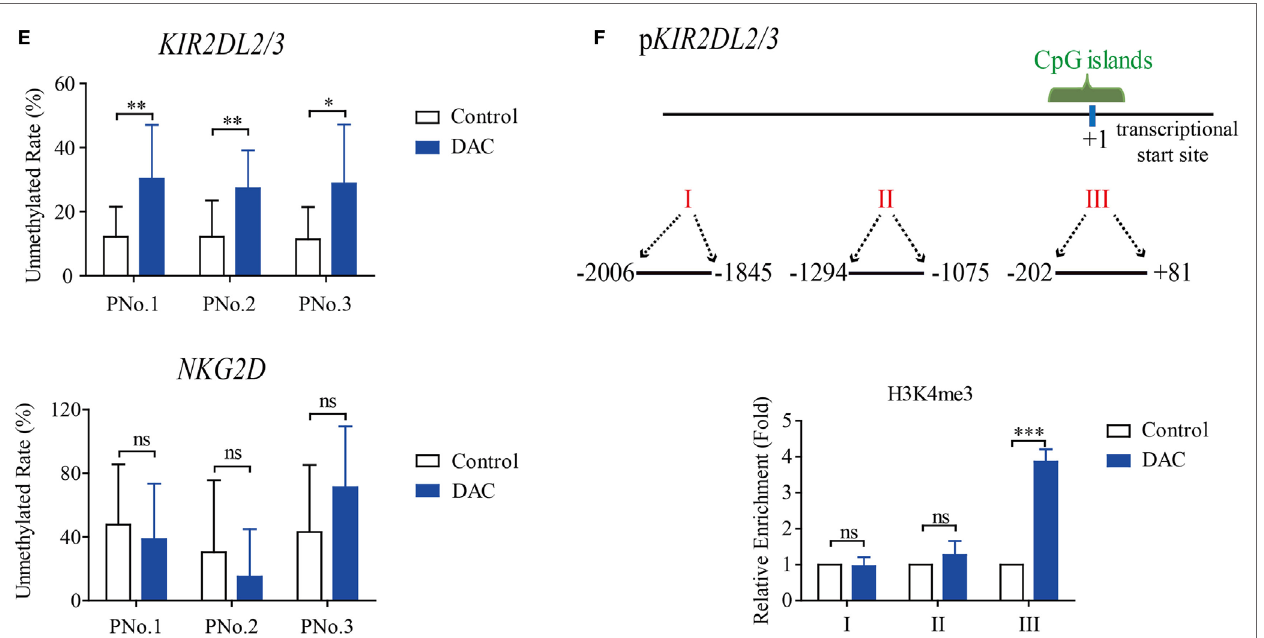
FigUre 4 | Decitabine increased demethylation of KIR2DL2/3 promoter, which was beneficial to the transcription of KIR2DL2/3 in gamma delta ( γδ ) T cells. (a) qRT-PCR analysis of KIR2DL2 and KIR2DL3 expression on γδ T cells exposed to 0.5 µM DAC for 48 h. Data are expressed as the expression of KIR2DL2 and KIR2DL3 mRNA on DAC-treated γδ T cells relative to that on γδ T cells (*** p < 0.001; n = 3). (b) The genes around the transcriptional star sites (TSS) (marked green) of KIR2DL2 and KIR2DL3 are nearly the same, except for two bases (marked red). There are 12 CpG sites (marked purple) around the TSS of KIR2DL2 and KIR2DL3 genes. (c,D) DNA methylation of the promoters of both KIR2DL2/3 and NKG2D in γδ T cells. The upper images show the schematic diagram of CpG islands in KIR2DL2/3 and NKG2D promoters. Vertical lines: methylation sites. The lower images show DNA methylation of KIR2DL2/3 and NKG2D promoters in γδ T cells treated with and without (control) DAC for 48 h from three patients. Open circles: unmethylated CpGs; solid circles: methylated CpGs. (e) Statistical analysis of the demethylation states of KIR2DL2/3 and NKG2D promoters in γδ T cells from three patients (* p < 0.05; ** p < 0.01; ns, not significant). (F) Three regions (I, II, and III) including TSS ( + 1) of KIR2DL2/3 were analyzed by chromatin immunoprecipitation qPCR for H3K4me3 occupancy in the KIR2DL2/3 promoter of γδ T cells treated with and without (control) DAC for 48 h. Enrichment of KIR2DL2/3 promoter-specific DNA sequences was measured using quantitative PCR. Data are shown from three independent experiments and each PCR was performed in triplicate (*** p < 0.001; ns, not